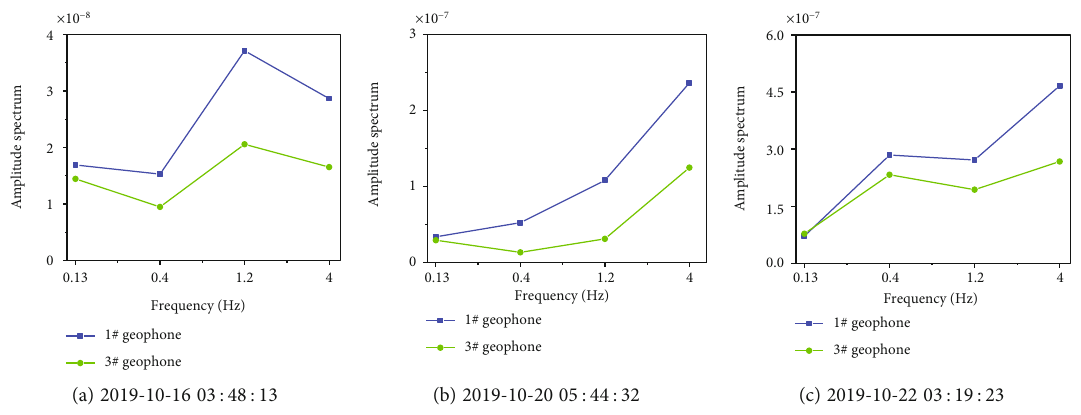
Figure 17: Frequency-spectrum evolutions of P-waves monitored by #1 and #3